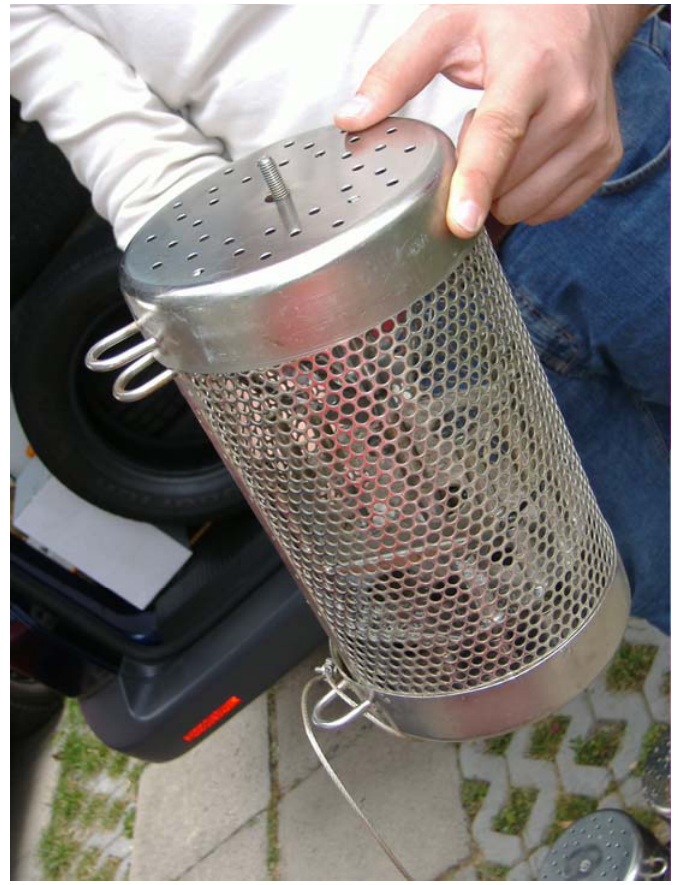
Figure 4. Semi-permeable membrane